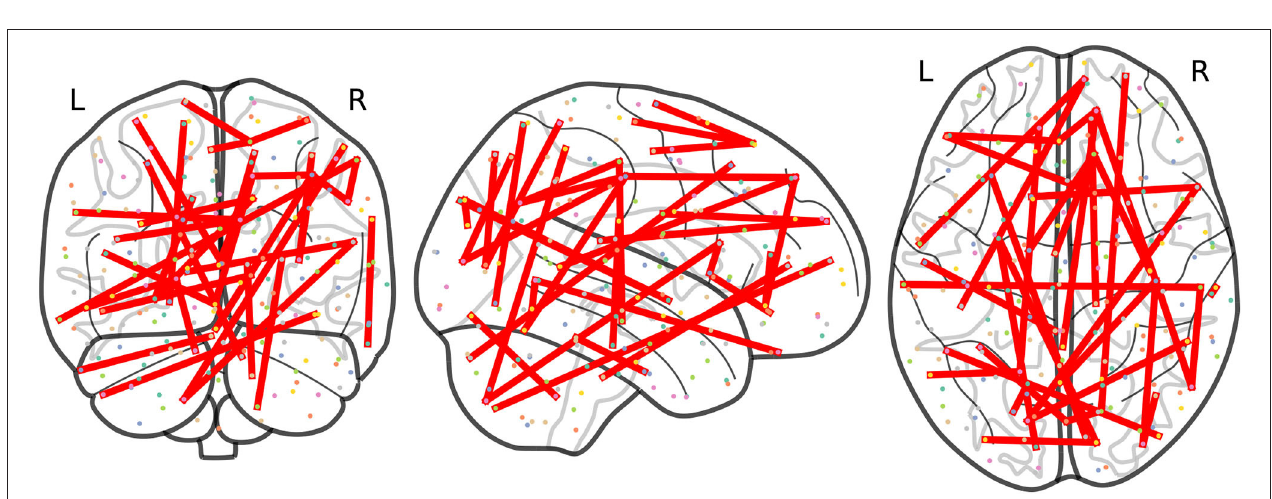
FIGURE 9 | Anomalous connections obtained by thresholding the frequency matrix for non-harmonized matrices at F ij ≥ 3. In total, the 21 anomalous connections are displayed. Notice the lack of anomalies involving the posterior parietal cortex and the cerebellum.